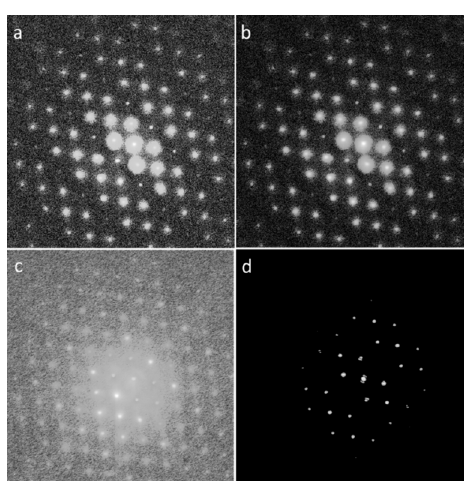
Figure 5. Intensity-rescaling on the GaAs/Znse (110) ED-pattern: ( a ) measured diffraction pattern; ( b ) restored pattern; ( c ) difference between the measured and the restored patterns; ( d ) anti-symmetric component Δ I of the restored pattern.